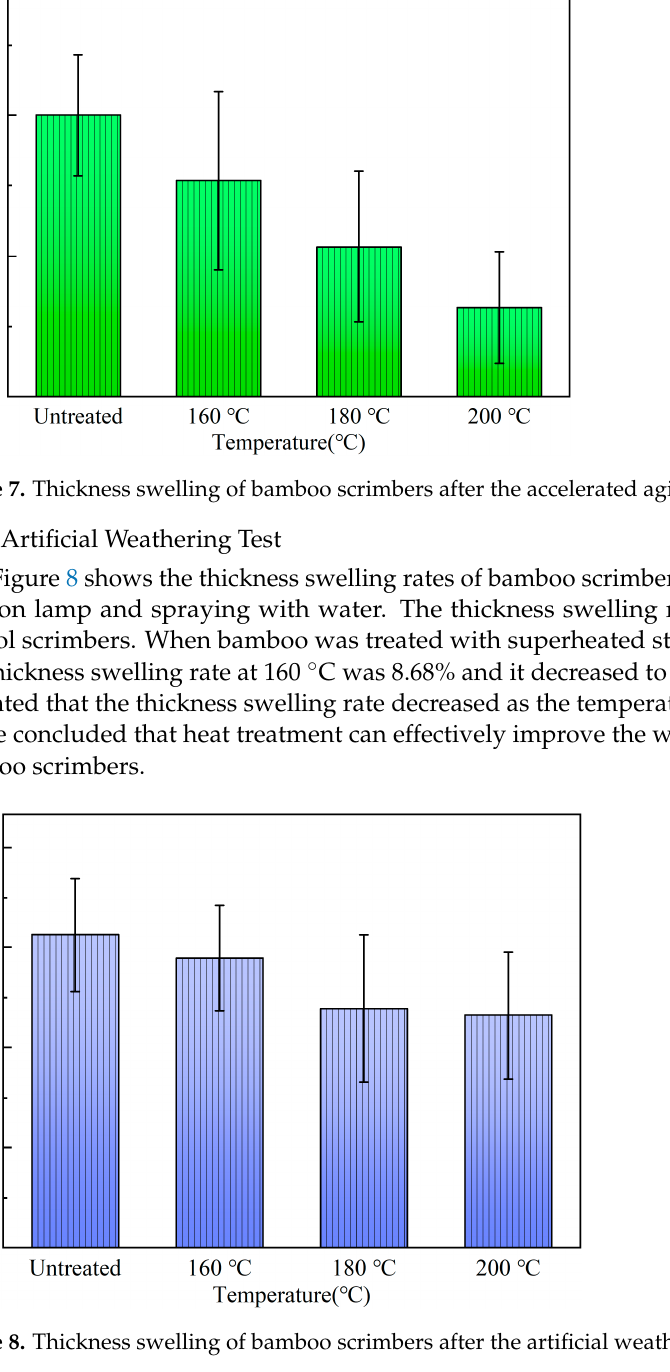
( c ) Figure 9. Surfaces of (a) 160, (b) 180 and (c) 200 °C -treated bamboo scrimbers attacked by white- rot fungi.